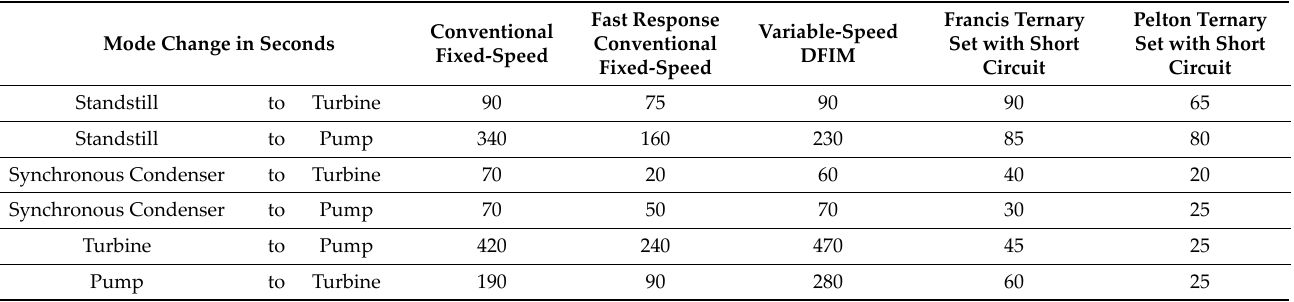
Table 1. Comparison of mode change times (in seconds) for various operating concepts. Syn‑ chronous Condenser Mode: the runner is rotating in air and the motor‑generator supplies reactive power to the